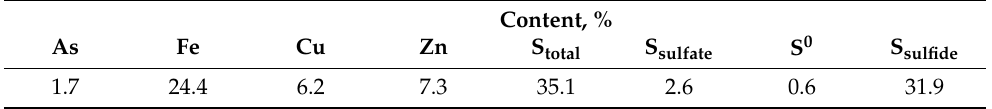
Table 1. Element content in the